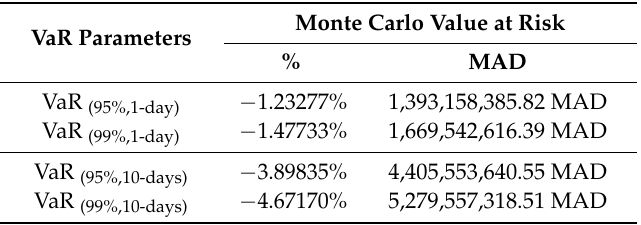
Table produced on Excel under VBA by the